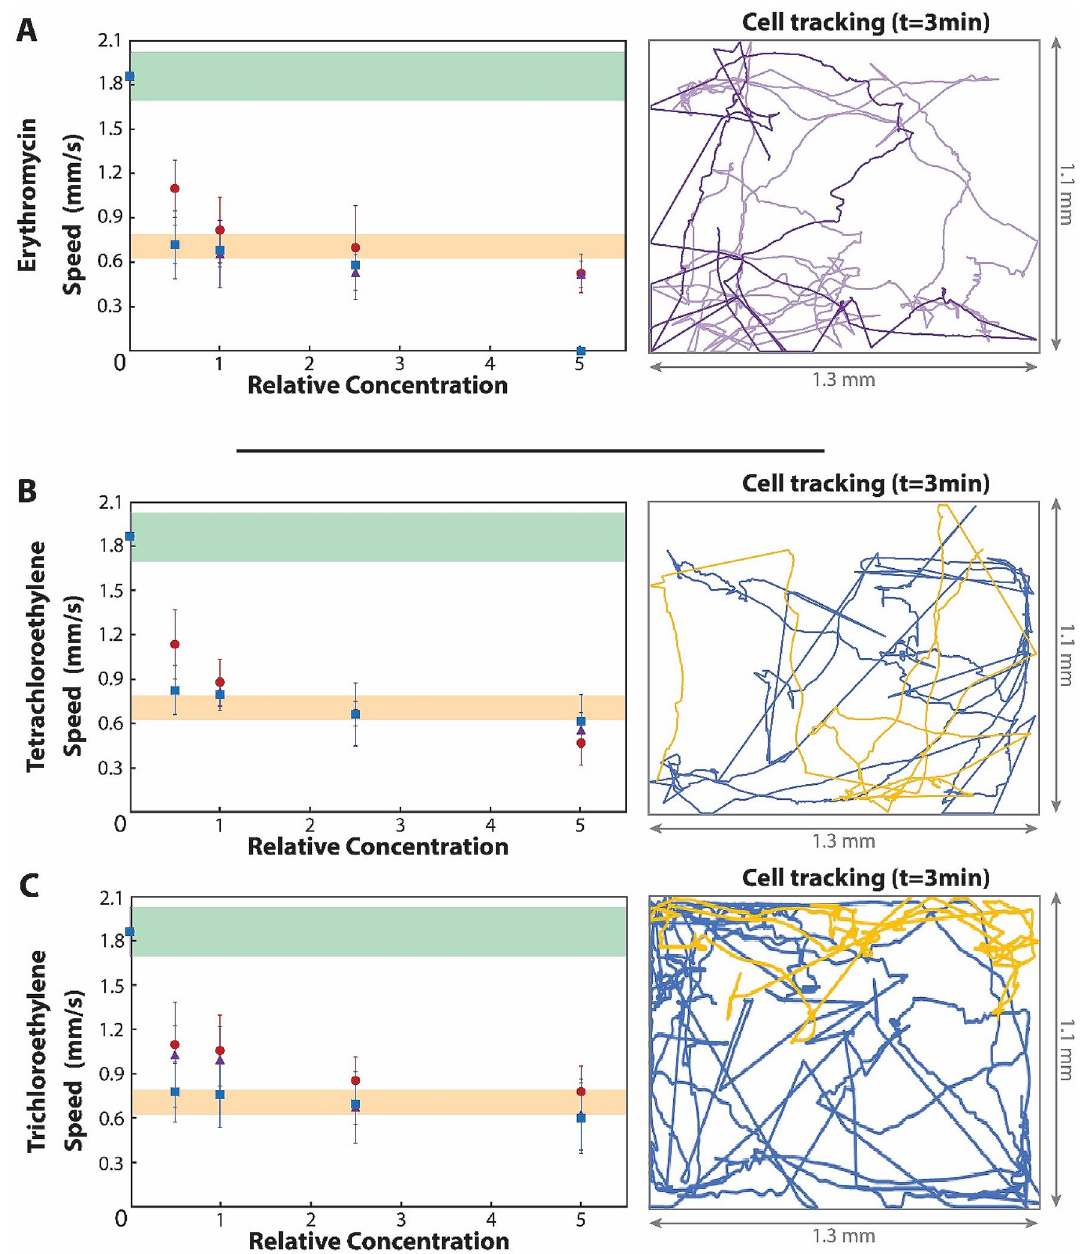
Figure 3. Measurement of the movement of Paramecium in the presence of organic pollutants. ( A ) Movement of Paramecium in Erythromycin solutions. The color code of the graph is similar to that in Fig. 2. The PL of erythromycin is 0.1 µg/l. Paths at the right side are for PL (light purple) five times PL (dark purple). ( B ) Swimming speed of Paramecia in samples contaminated with tetrachloroethylene (PL = 40 µg/l). Paths are for PL (blue) and five times PL (yellow). ( C ) Same representation but for trichloroethylene at (PL = 20 µg/l). Error bars represent standard deviation of the average speeds, and the paths are represented over the whole area of the chamber. Statistical significances are analyzed in Supplementary Fig. 2 and cumulative distances in Supplementary Fig.